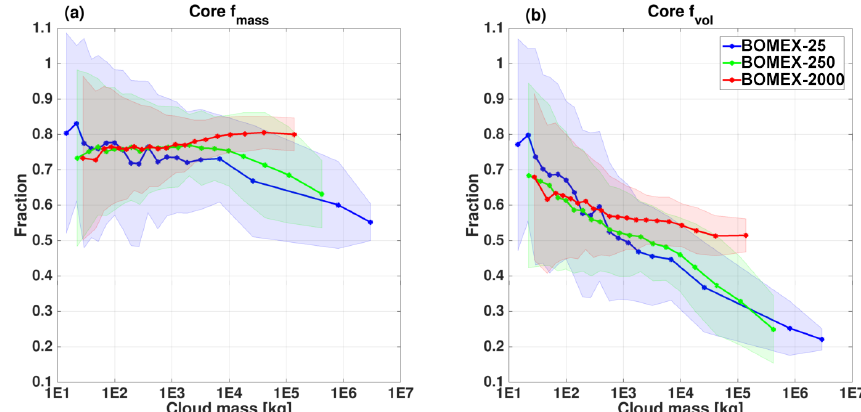
Figure 6. Average core mass fraction (a) and volume fraction (b) values for different aerosol concentrations, as indicated in the legend. The average only includes growing branch clouds from within the CvM space (i.e., clouds located in proximity to the adiabat). The core here is defined according to RH > 100%